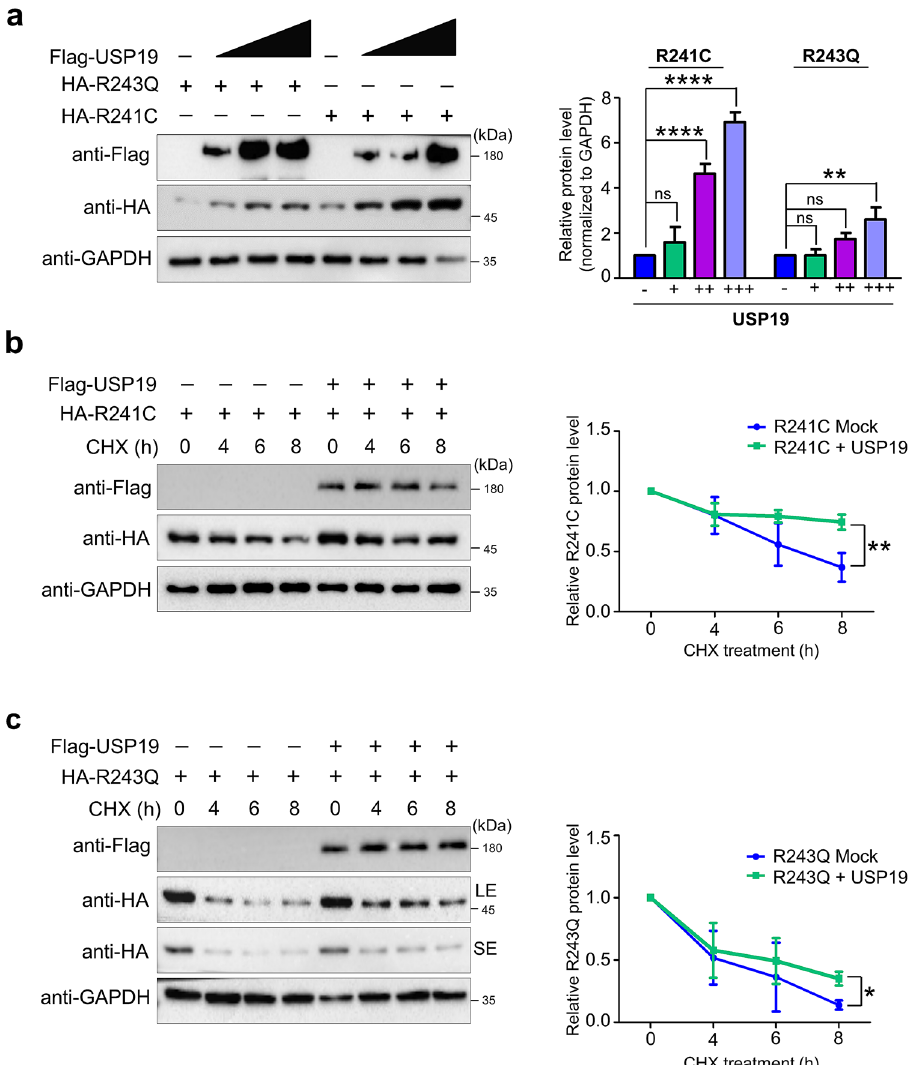
Figure 4. USP19 extends the half-lives of PAH variants. ( a ) HEK293 cells were transfected with PAHwt, R241C, or R243Q and an increasing concentration (0, 100, 250, 500 ng/mL) of USP19 and analyzed by Western blotting. ( b ) HEK293 cells were transfected with R241C and USP19, treated with CHX (150 μg/mL), harvested at different time points, and analyzed by Western blotting with the antibodies indicated. c HEK293 cells were transfected with R243Q and USP19, treated with CHX (150 μg/mL), harvested at different time points, and analyzed by Western blotting with the antibodies indicated (SE: short exposure; LE: Long exposure). The band intensities of R241C and R243Q from ( a – c ) were estimated using ImageJ software, normalized to GAPDH, and represented graphically. Data are presented as the mean and standard deviation of three independent experiments. Šídák’s multiple comparisons test was used to evaluate the P value (* P < 0.05, ** P < 0.005, **** P < 0.00005; ns denotes